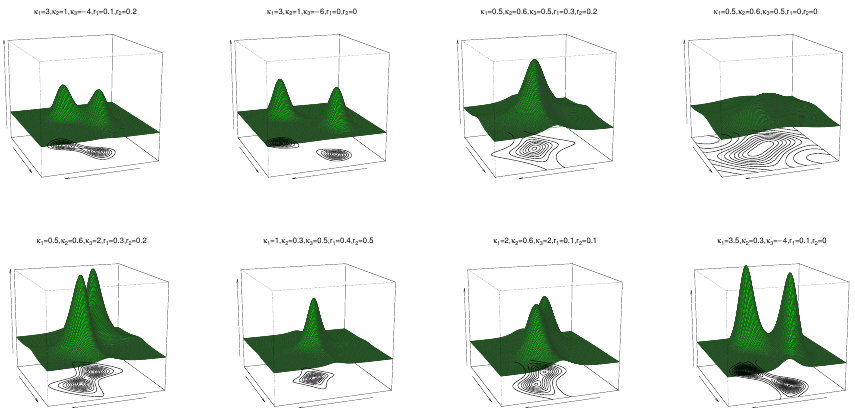
Figure 4. Pdf and contour plots of the transformed sine model (16) for µ 1 = µ 2 = 0 and different values of κ 1 , κ 2 , κ 3 , r 1 , and r 2